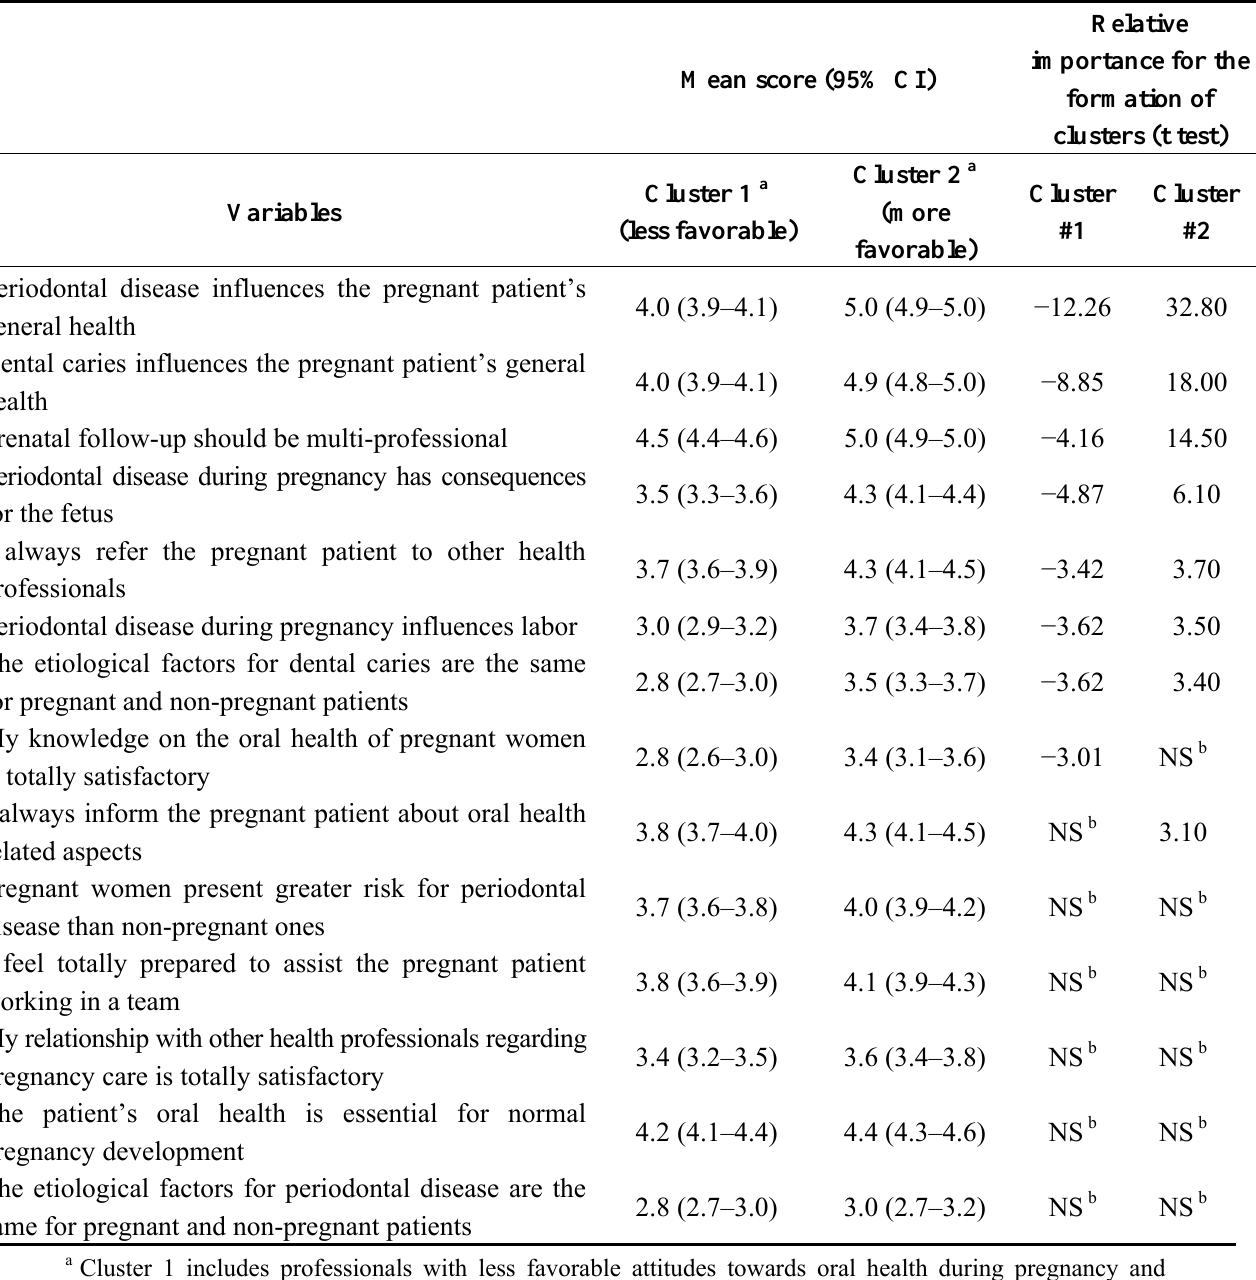
Table 1. Mean scores and importance of variables in cluster